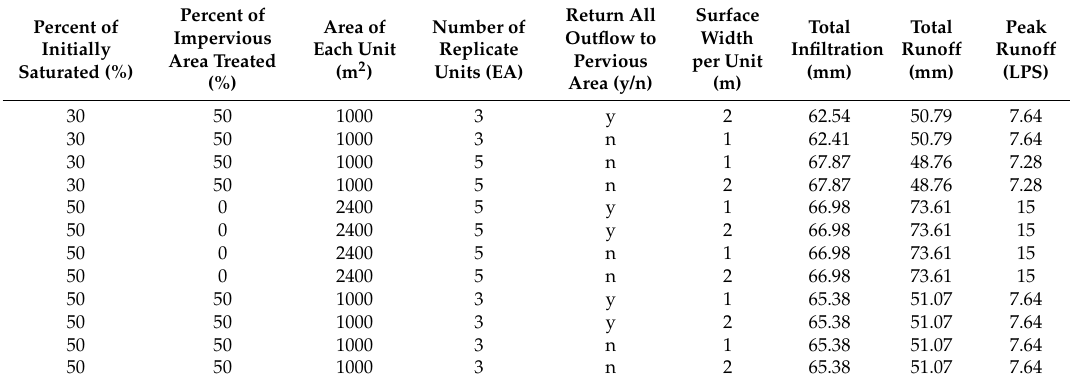
Table 6. Results of the simulated scenarios for the LID planning parameters (step 10 of the WMAM).